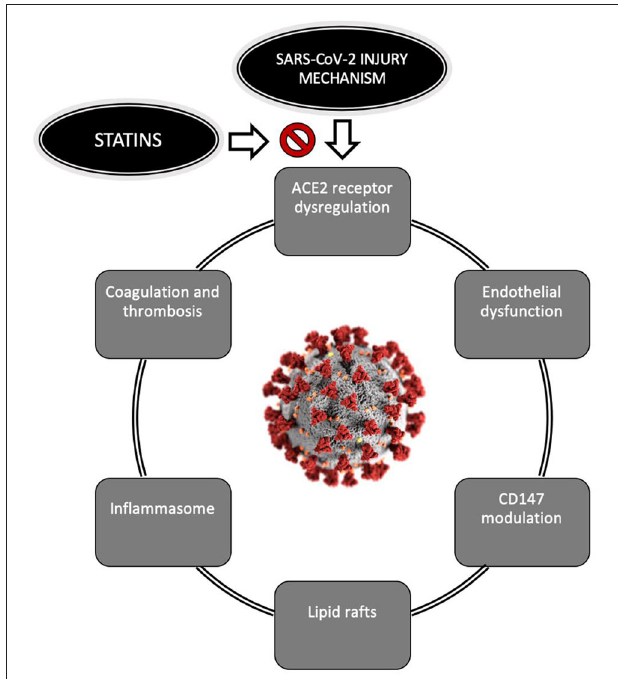
FIGURE 1 | Pathophysiological mechanisms of COVID-19 which statins may affect. COVID-19, Coronavirus disease; CDC, Center for Disease Control. The SARS-CoV-2 image was downloaded from the CDC public library (https://phil.